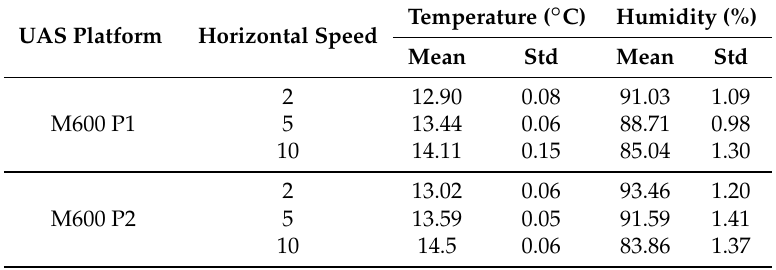
Figure 13. The plot shows three different horizontal “transect” flights at different horizontal (H) speeds at 50 m AGL. The surface wind was 2 m/s from 290–308 ◦ relative to the north, and the sky is partly cloudy. The solid line plots indicate data from M600P1, and the dashed lines indicate data from the M600P2. The blue (M600 P1) and light blue (M600 P2) scatter dots indicate transects 1 and 3, while the red (M600 P1) and orange (M600 P2) are transects 2 and 4. Figure 12 shows the direction of air flow inside the housing, the surface wind, and the horizontal transects for each of the transects for both UASs. The data shown here is not filtered/corrected for sensor response characteristics. Table 4. Statistics for the measurements presented in Figure